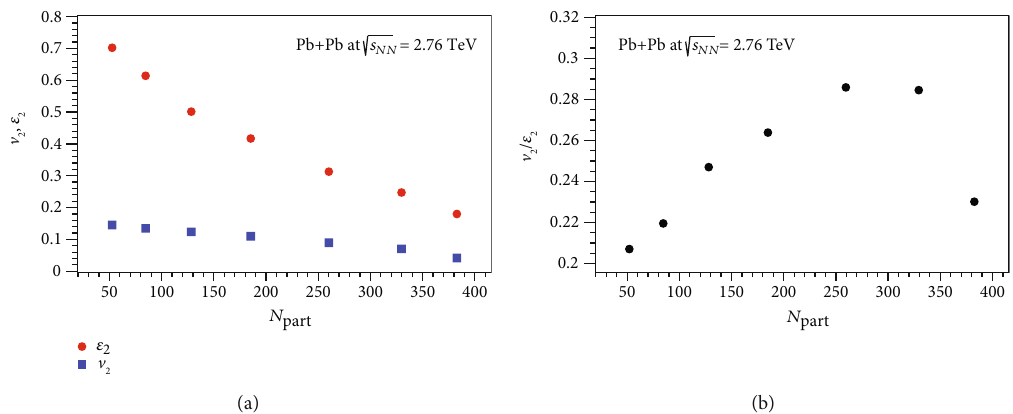
p ffiffiffiffiffiffiffiffi = 2 : 76TeV . (b) The ratio s NN